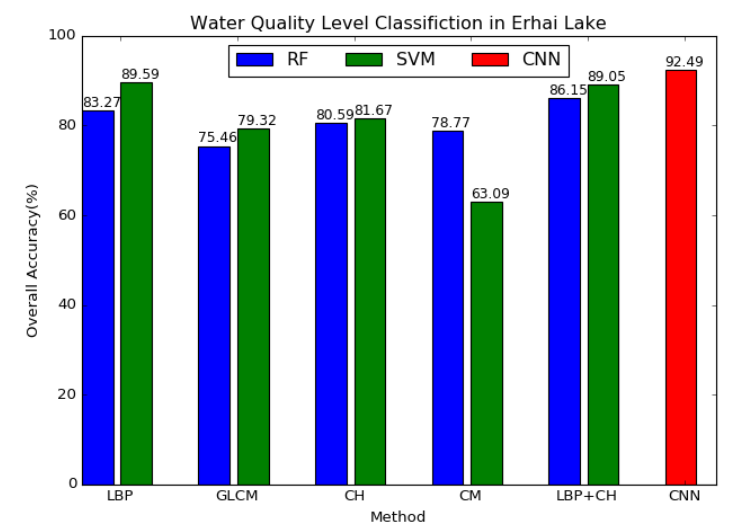
Figure 6. Comparisions of water-quality classification performance in Erhai Lake.